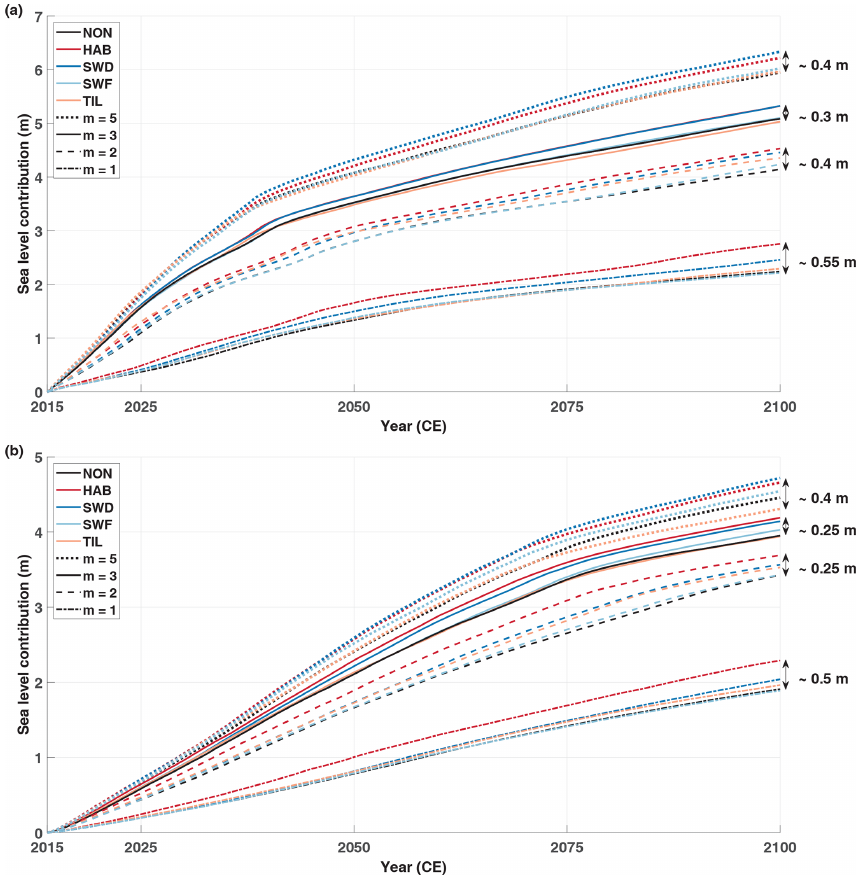
Figure 5. Sea level contribution from the Antarctic ice sheet until 2100 for ABUK (a) and ABUM (b) experiments. Line colours represent the different subglacial models (Table 2), and the different line styles express the exponent value of the basal sliding